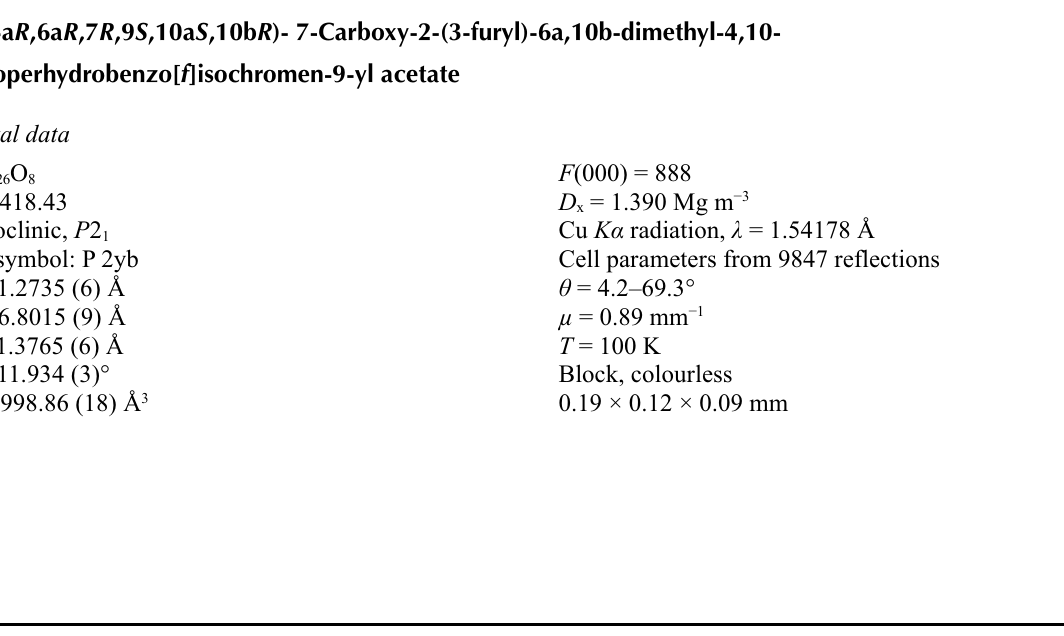
Figure 1 One molecule in the asymmetric unit of the title compound with displacement ellipsoids drawn at the 50% probability level for non-H atoms. The second molecule is closely